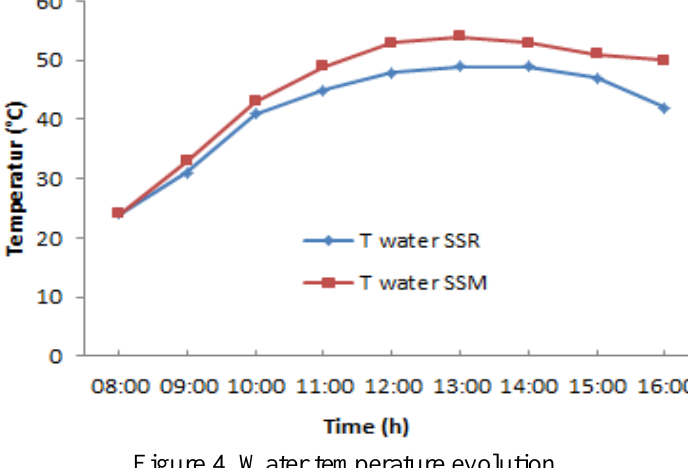
Figure 4. Water temperature